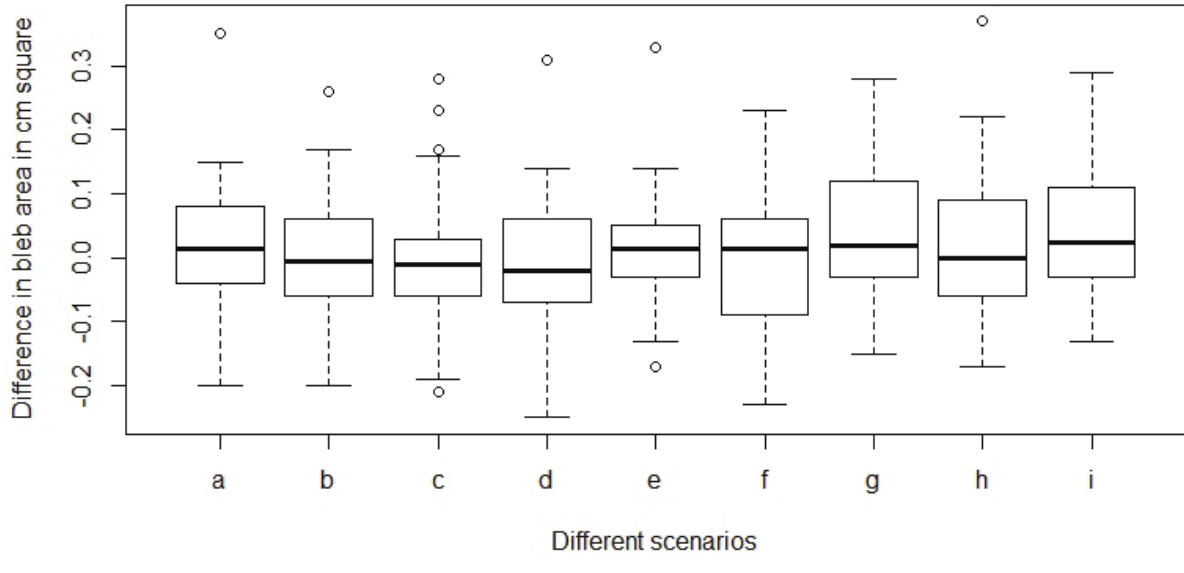
Figure 3. Box-plots for differences in measured bleb area in six different lighting scenarios for native camera application: (A) White- light close filmic vs yellow-light close filmic; (B) White-light close native vs yellow-light close native; (C) White-light close filmic vs yellow-light close native; (D) White-light intermediate filmic vs yellow-light intermediate filmic; (E) White-light intermediate native vs yellow-light intermediate native; (F) White-light intermediate filmic vs yellow-light intermediate native; (G) White-light distant filmic vs yellow-light distant filmic; (H) White-light distant native vs yellow-light distant native; and (I) White-light distant filmic vs yellow-light distant